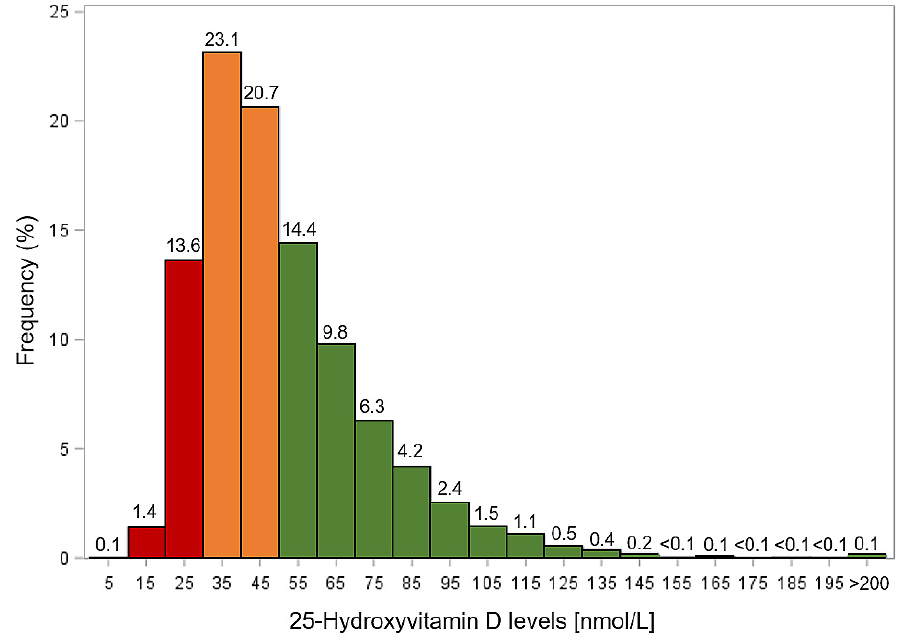
Figure 1. Distribution of 25-hydroxyvitamin D (25(OH)D) levels among study participants. Red columns: vitamin D deficiency; orange columns: vitamin D insufficiency; green columns: sufficient vitamin D status.